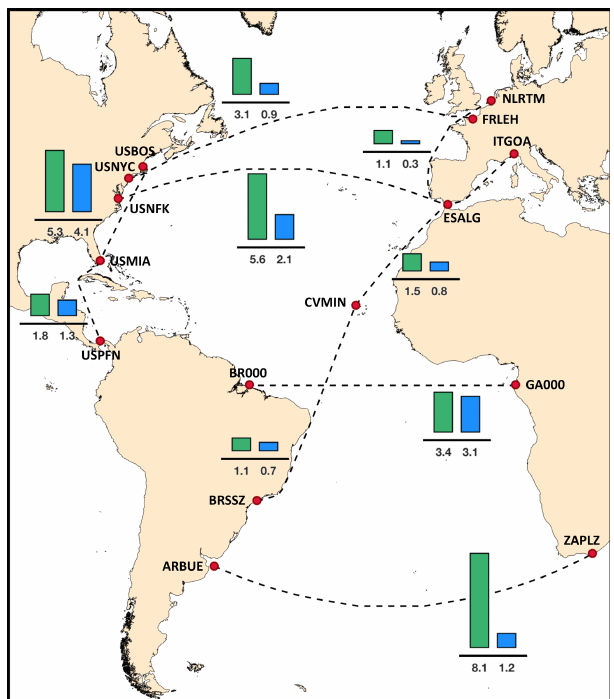
Figure 11. Mean relative EEOI savings (%) for several routes in the Atlantic Ocean. The values displayed in the vertical bars refer to the annual average of the mean savings for the return voyages (i.e. mean values along the rows of Fig. 10) sailed along the op- timal tracks of cw type. The green bars refer to total savings, or − (cid:49)( EEOI ) cw , g , while the blue bars refer to the ocean currents con- tribution, or − (cid:49)( EEOI ) cw , w